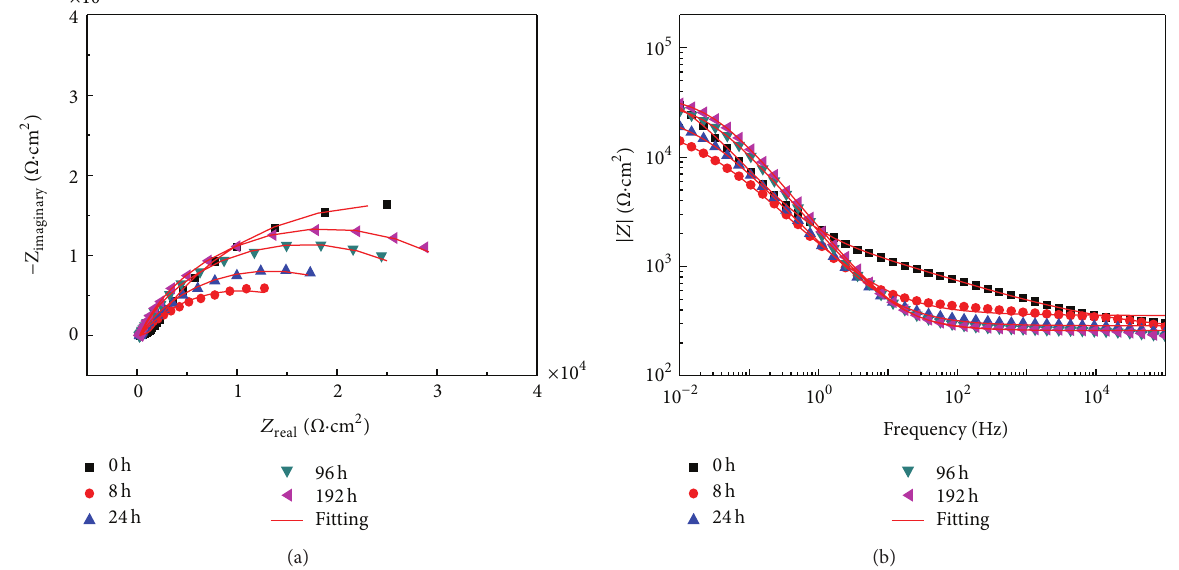
Figure 3: Impedance spectra of painted samples with scratch after different immersion time in 3.5 wt% NaCl solution: (a) Nyquist plots and (b) Bode plots.